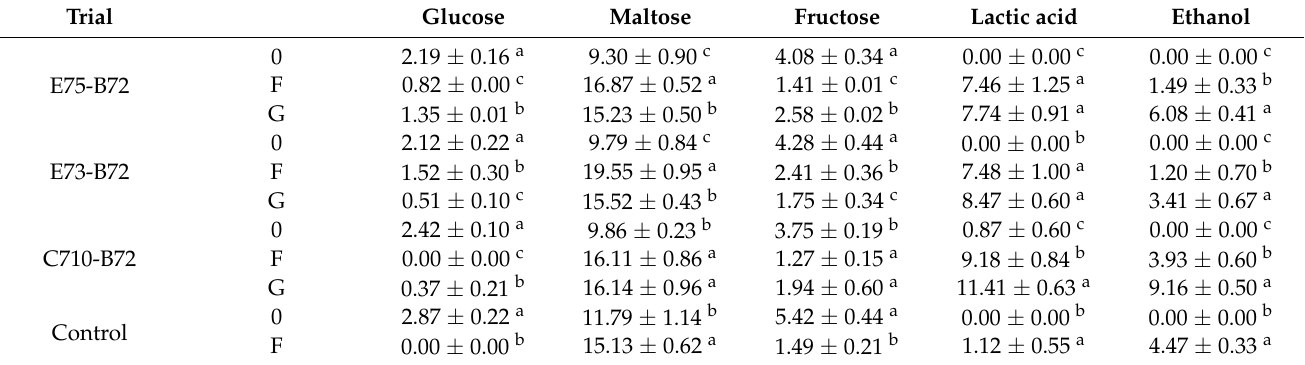
Table 4. Reducing sugars and organic acids (g/kg) by HPLC during sourdoughs fermentation at time 0 and after 16 h for fresh (F) and granulated (G) cells. Control is made with fresh bakery yeast. Analyses were performed in triplicate. Results are reported as mean values ± SD. Different superscript letters in a column indicate statistically significant differences ( p <